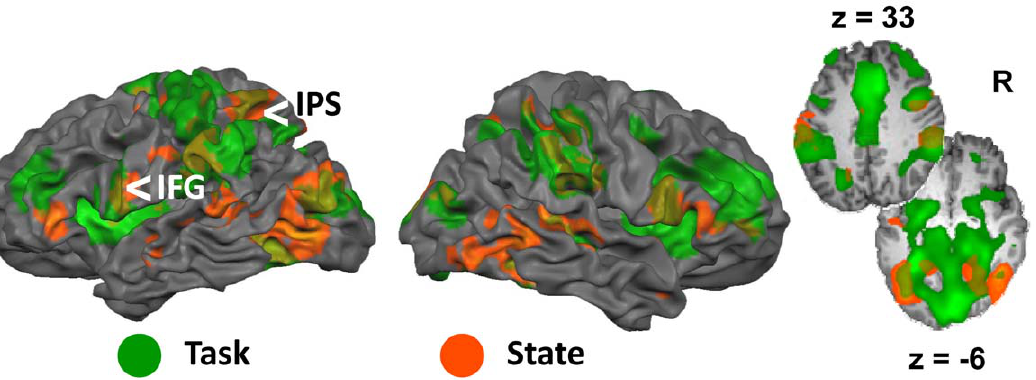
Figure 4. Effect of sleep deprivation on activation associated with selective attention for houses. Brain regions that showed a significant effect of state on activation in the Attend House (AH) vs. baseline contrast ( p , .001 uncorrected; in orange). This finding was similar to the main effect of state obtained using an ANOVA analysis. For comparison, the regions showing the effect of task are overlaid in green and the overlap between regions showing task and state effects are in an intermediate color. IPS = intraparietal sulcus; IFG = inferior frontal gyrus.